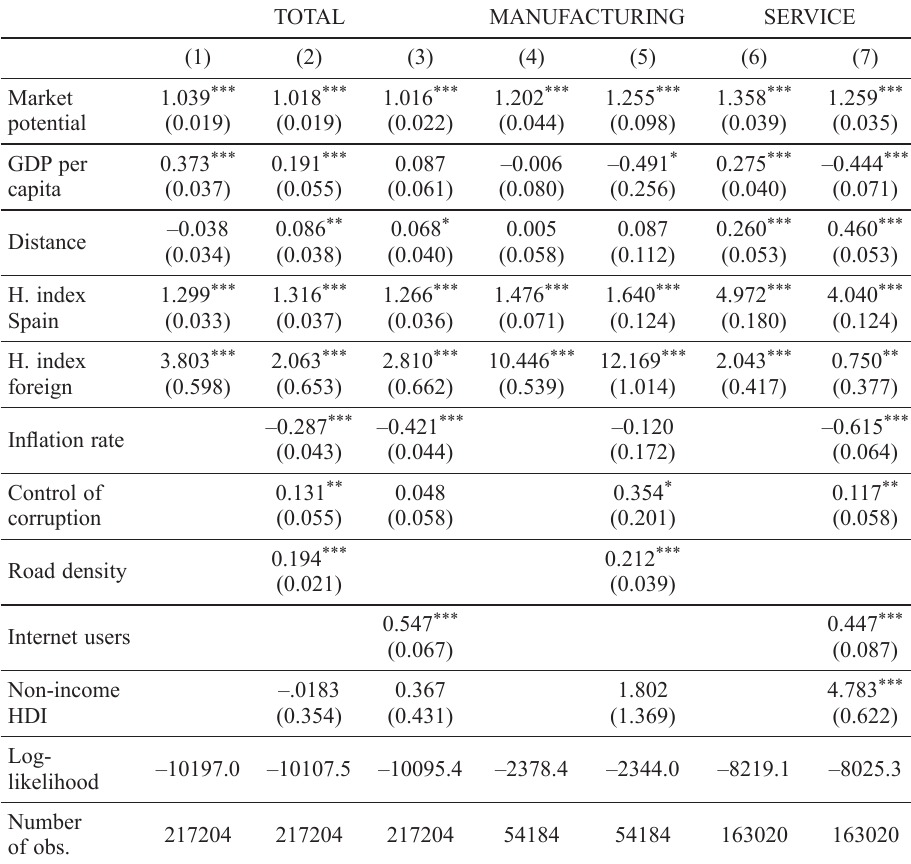
Table 1. Regression results from conditional logit